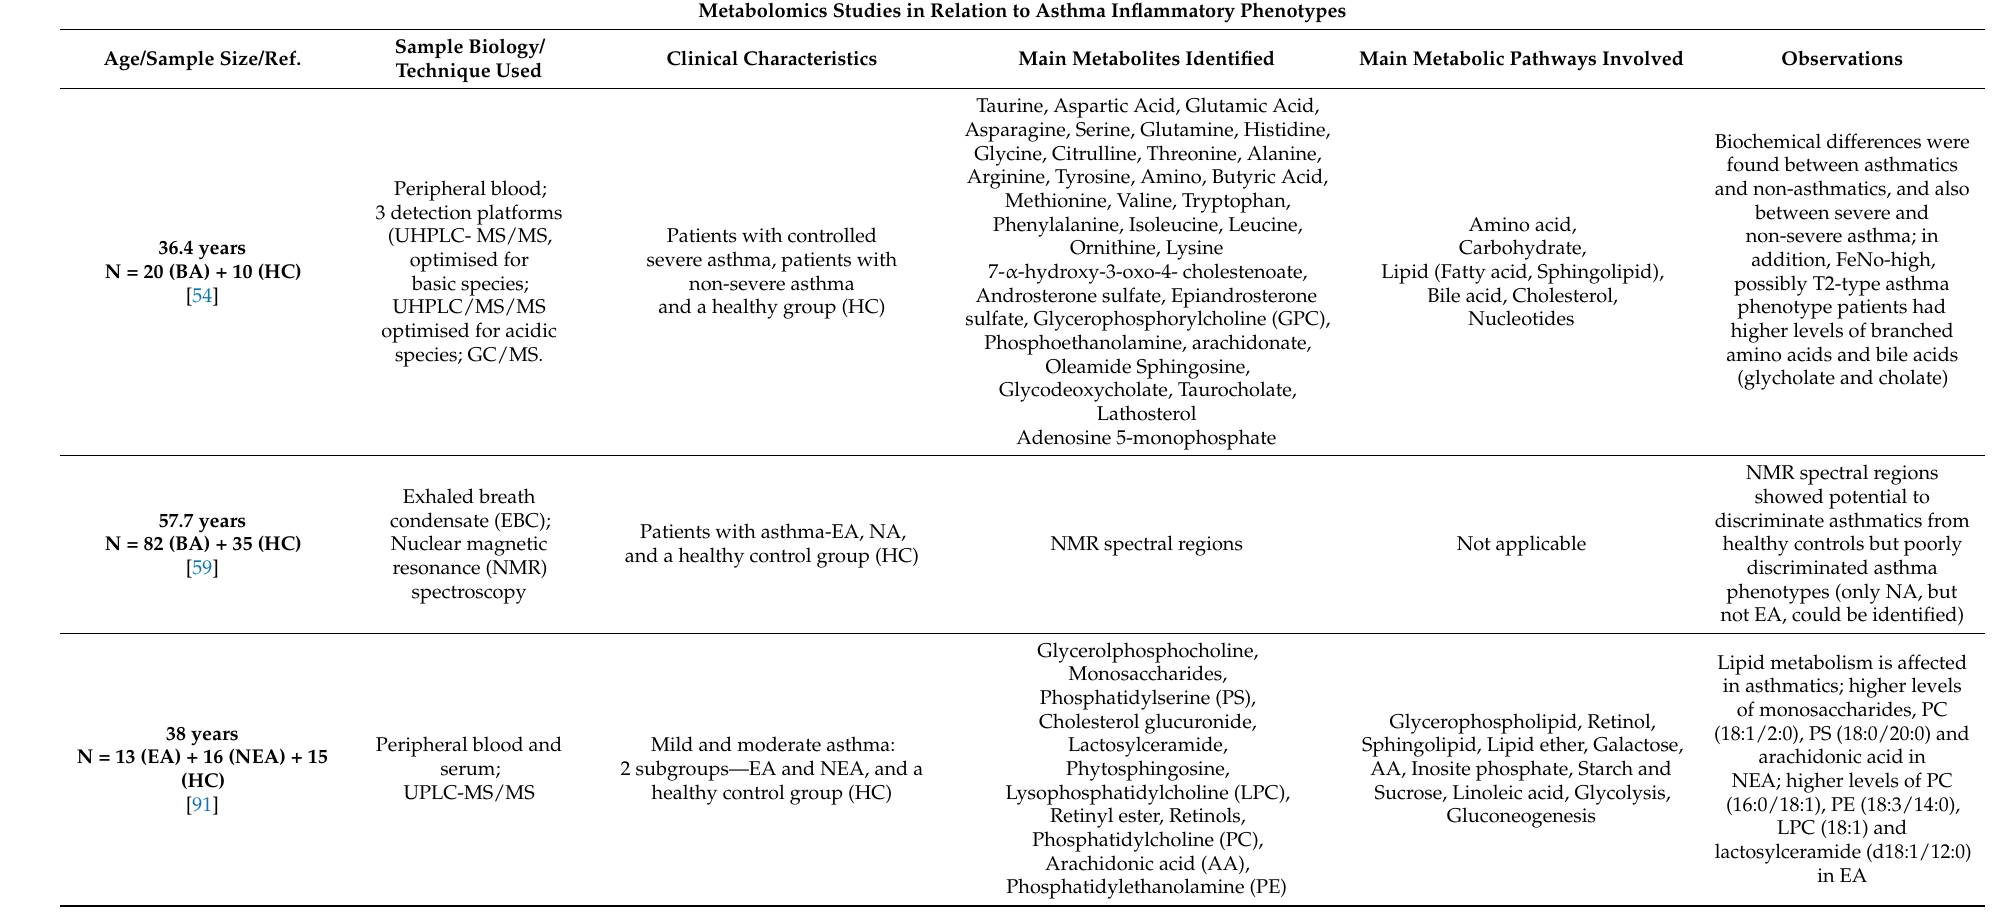
Table 1. Most representative metabolomics studies in adult asthma, including relationship with inflammatory or clinical phenotypes. Metabolomics Studies in Relation to Asthma Inflammatory Phenotypes Age/Sample